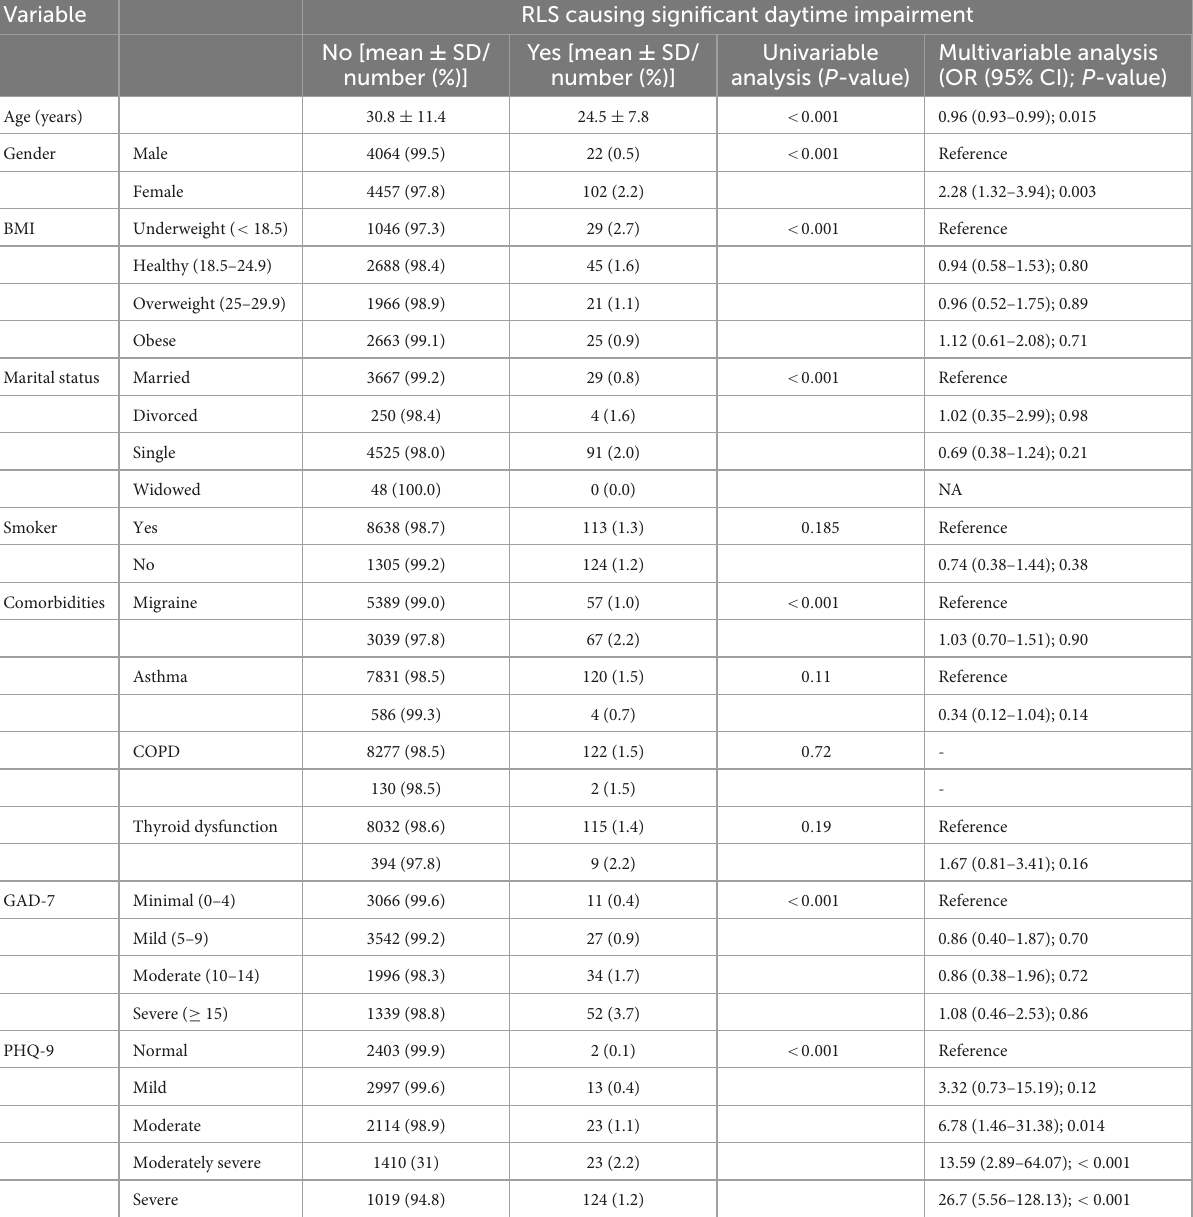
TABLE 3 Univariate and multivariate analysis of risk factors for restless legs syndrome (RLS) causing significant daytime impairment.